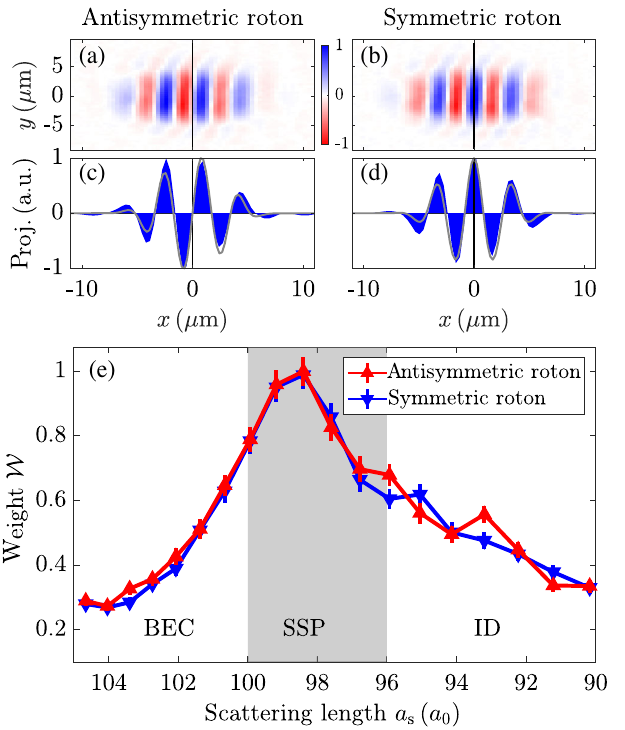
FIG. 5. Higher principal components corresponding to the phonons of the crystal and the BEC (a) – (c) including their Fourier transforms (d) – (f) and weights (g). (a) Quadrupole mode of the BEC. The antisymmetric (b) and the symmetric (c) breath- ing mode of the crystal show a clear splitting in their Fourier transform (e),(f). (g) Comparison of the mean absolute weights W of these modes featuring a clear overlap region that indicates a supersolid phase. The gray shaded area shows the previously determined supersolid region [30]. Error bars indicate the standard error of the mean. The weights are normalized to the weight of the antisymmetric roton mode at the transition point, which is the maximal weight of all principal components over the whole scattering length range.